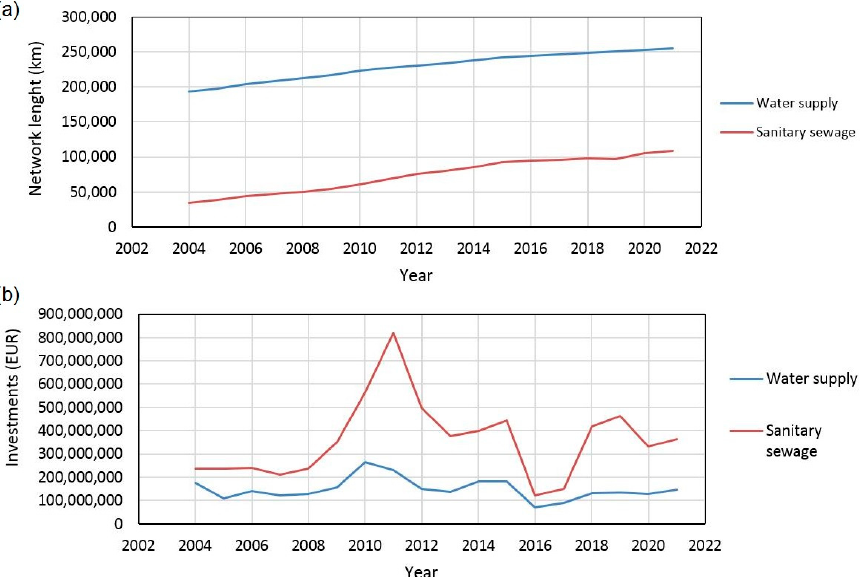
Figure 6. Development of rural water supply and sewage systems, data obtained from [66]: ( a ) length of rural water supply and sanitary sewage networks, ( b ) annual investments in rural water supply and sewage systems.